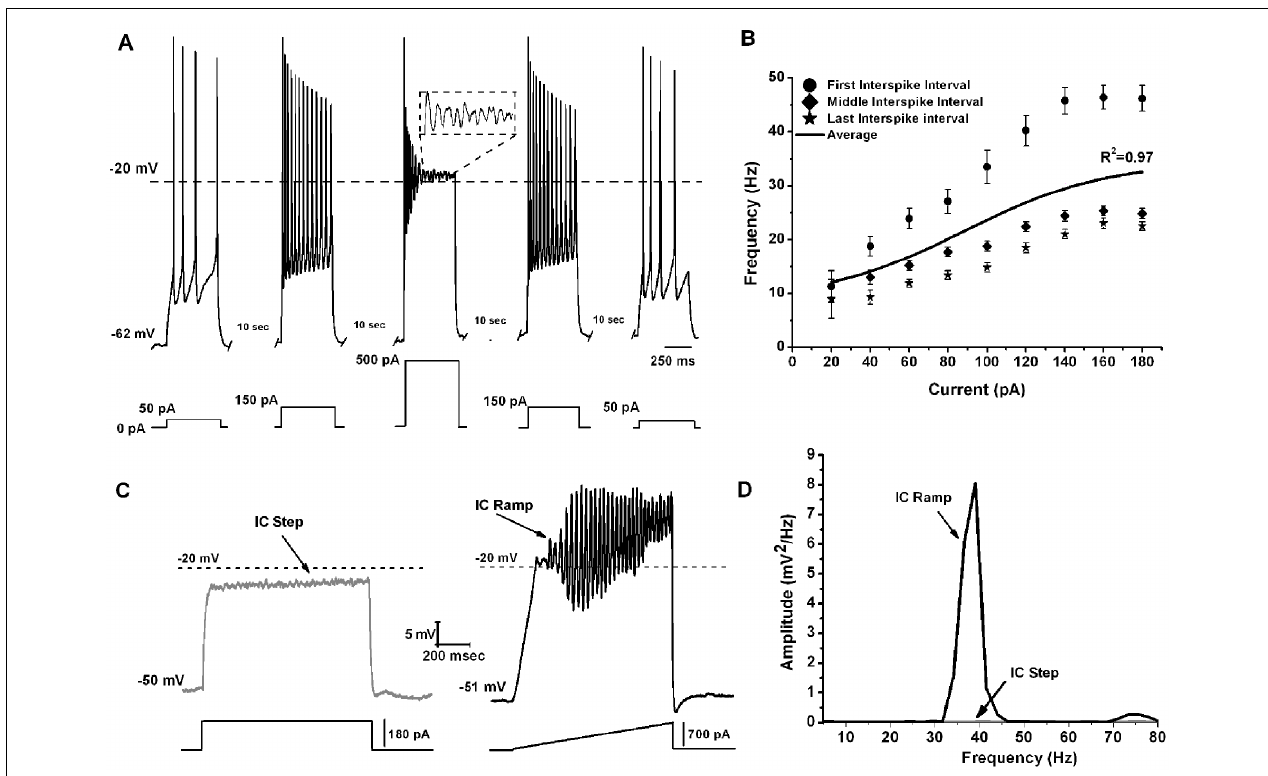
black line shows the average instantaneous firing frequency during the entire current step. Note that firing frequency did not increase linearly with increasing current during the last few steps (140–180pA), but instead plateaued at gamma frequency. (C) Representative membrane potential responses to depolarizing 1s square steps (left, gray record) and responses to depolarizing 1s ramps (right, black record) for the same Pf neuron. (D) Power spectrum corresponding to the records shown in (C)